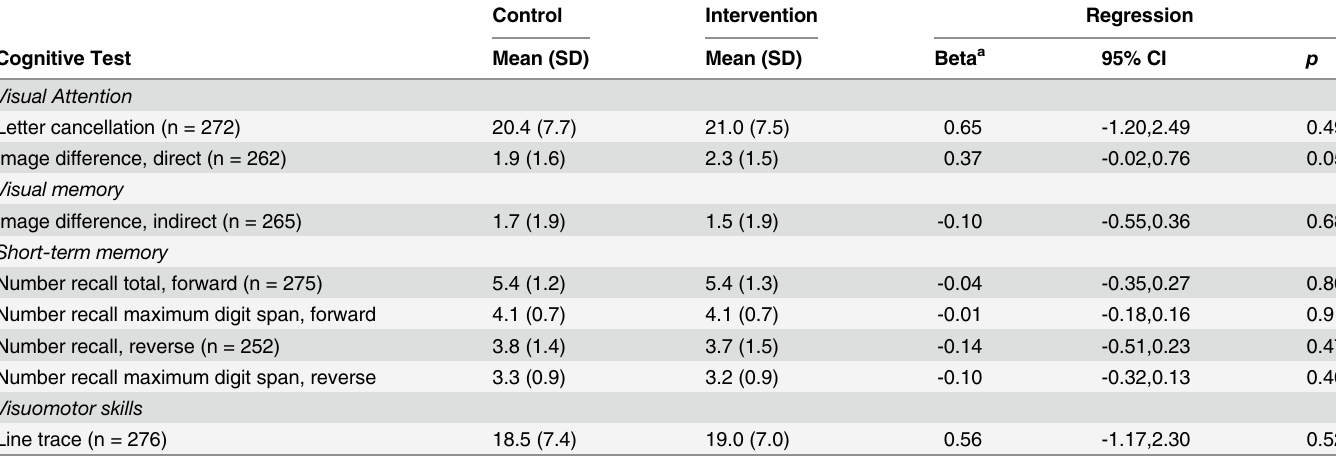
Table 4. Mean and standard deviation (SD) of cognitive tests by study arm, with multivariable linear regression models of the association between the provision of drinking water and cognitive performance among pupils in Zambia. Control Intervention Regression